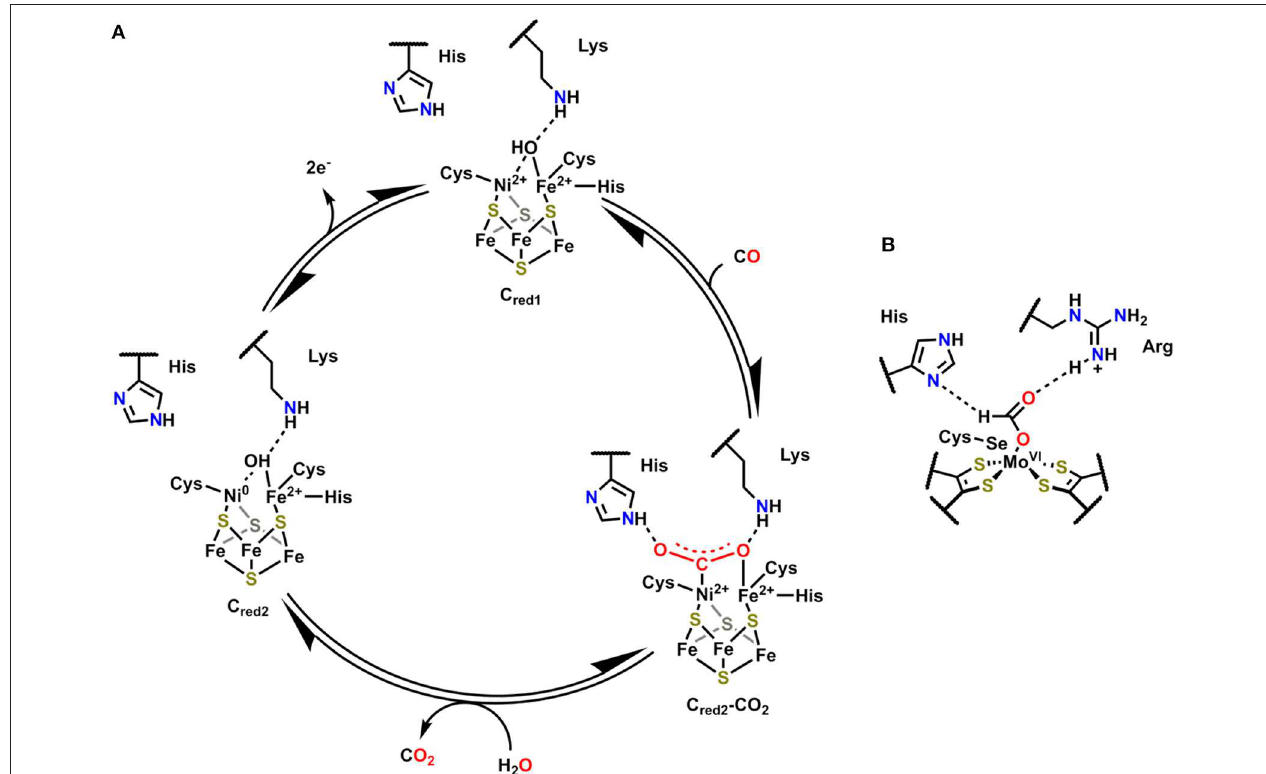
FIGURE 2 | (A) Proposed mechanism for CO oxidation by Ni,Fe CODH (Jeoung and Dobbek, 2007). (B) Active site of FADH in Escherichia coli with bound formate substrate ( Boyington et al., 1997).